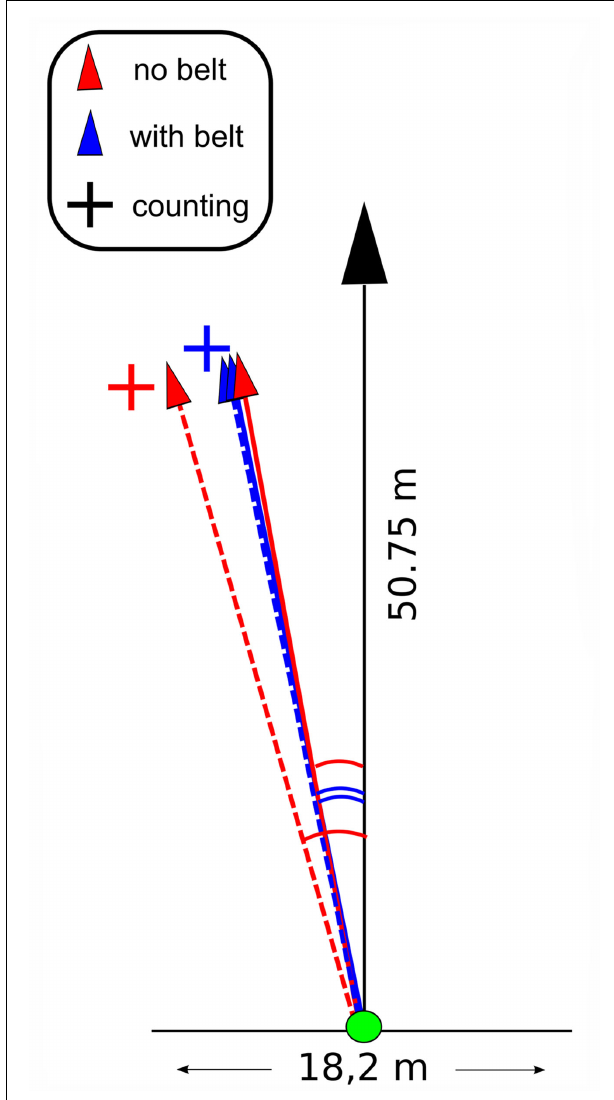
FIGURE 4 | Results of straight-line-walking. The black line is the straight line connecting one end of the experimental field to the other.The red (without belt) and blue (with belt) lines are trajectories of the subject’s walking direction.The plus-sign denotes the trials in which the subject did an additional subtraction task. In the condition without belt, the subject had a much larger error angle when his attentional resources where occupied by the subtraction task. For all other conditions, the subject had a smaller angular